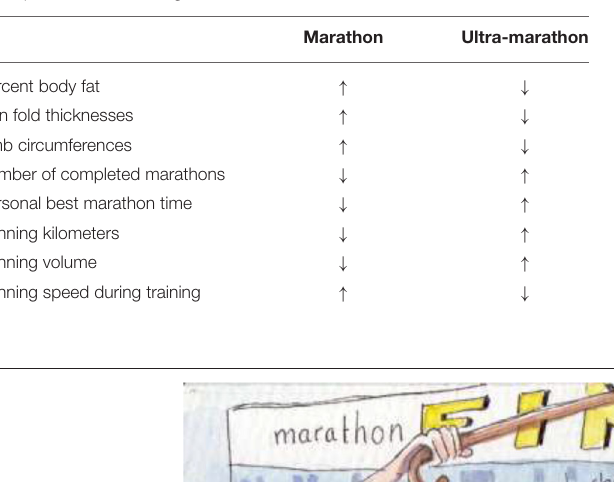
Frontiers in Physiology |